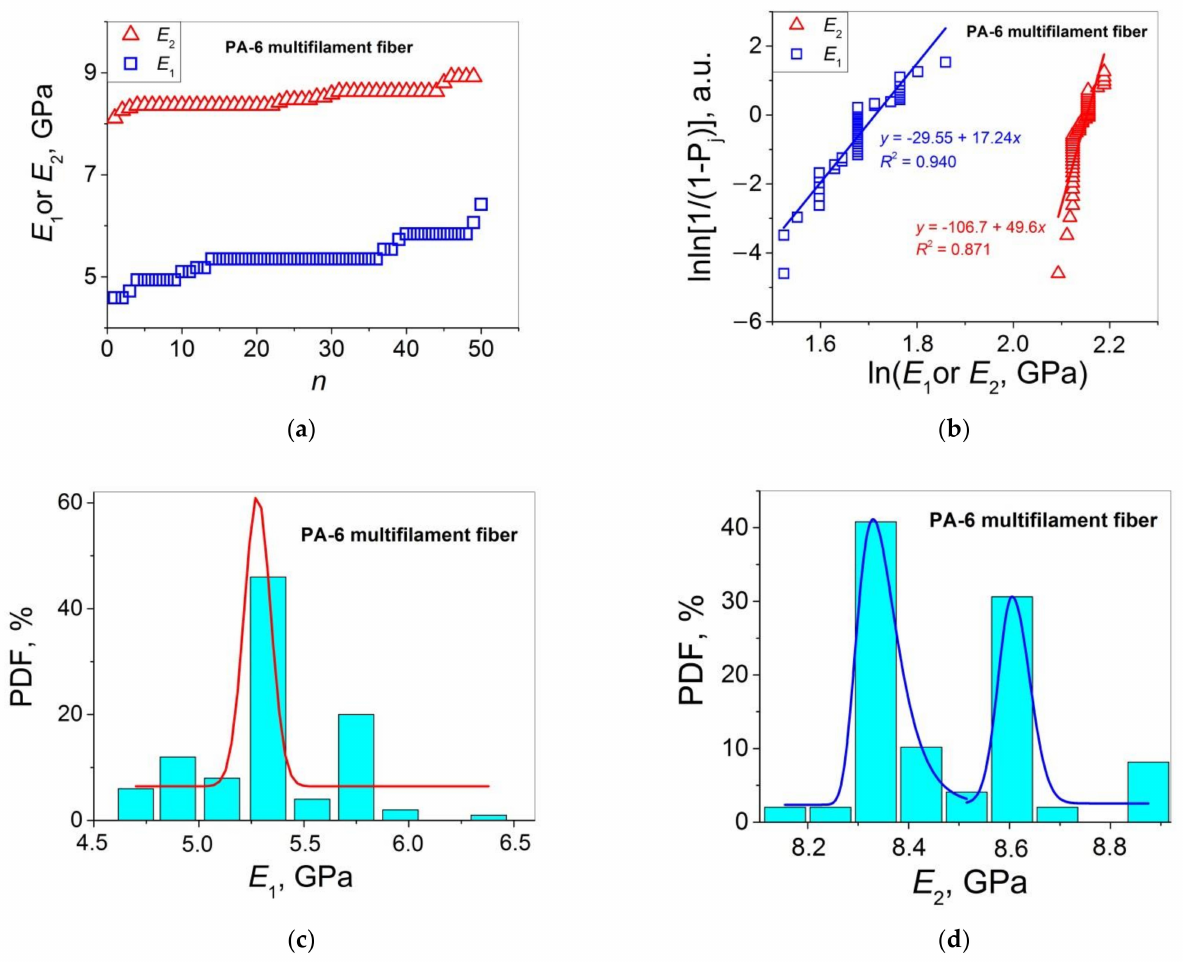
Figure 4. ( a ) Moduli E 1 and E 2 as functions of sample number n in an ascending order for PA 6 multifilament fibers; ( b ) Weibull’s plots for the data presented in ( a ); PDF vs. E 1 ( c ) and E 2 ( d ) for the data presented in ( a ); the bell curves are the Gaussian fitting results.